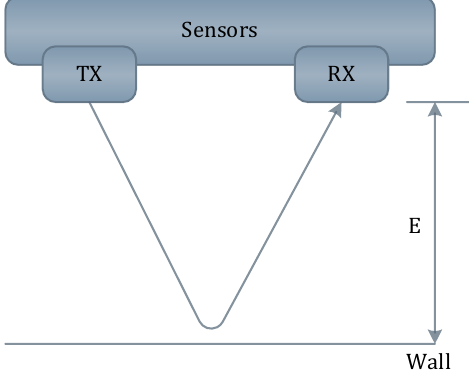
Wall Figure 4. Reflection of sequence of ultrasonic pulses between the sender and receiver. Figure 4.